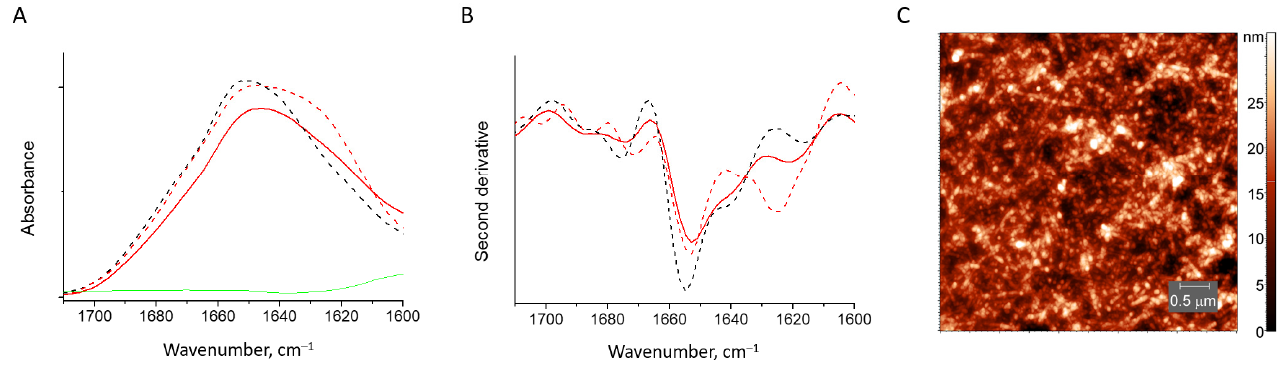
Figure 8. Absorbance spectra ( A ) and second derivative spectra ( B ) of HEWL fibrils (dashed red line), those mixed with sodium alginate (solid red line), native HEWL (black dashed line) and pure sodium alginate (green). AFM image of HEWL fibrils mixed with sodium alginate ( C ).